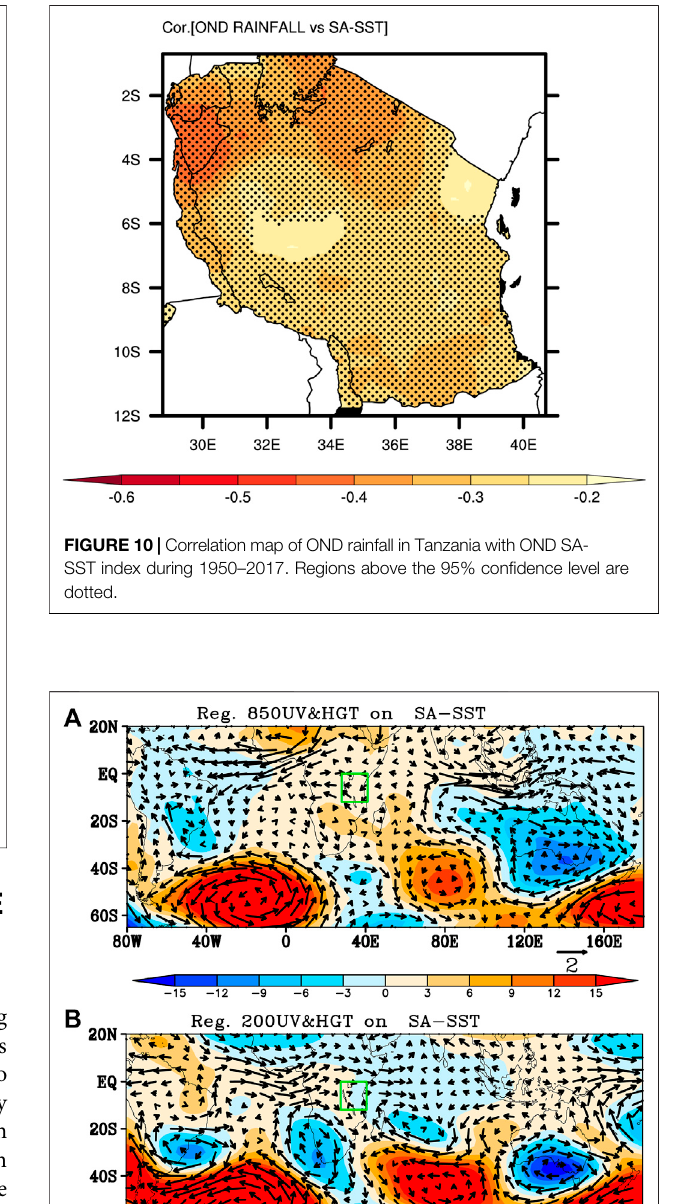
EA-SST (SA-SST) index ( Figure 5B ) is − 0.52 ( − 0.34), also